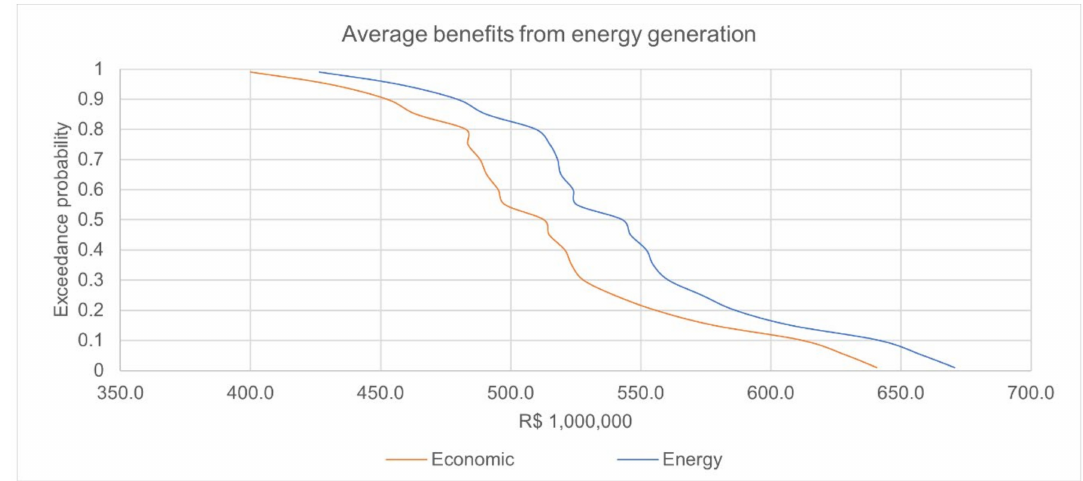
Figure 4. Exceedance probability curves of average economic benefits from energy generation.